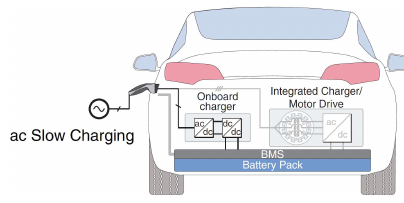
Table 1. Standards for ultra-fast charging systems. Standard CHAdeMO CCS Combo 1